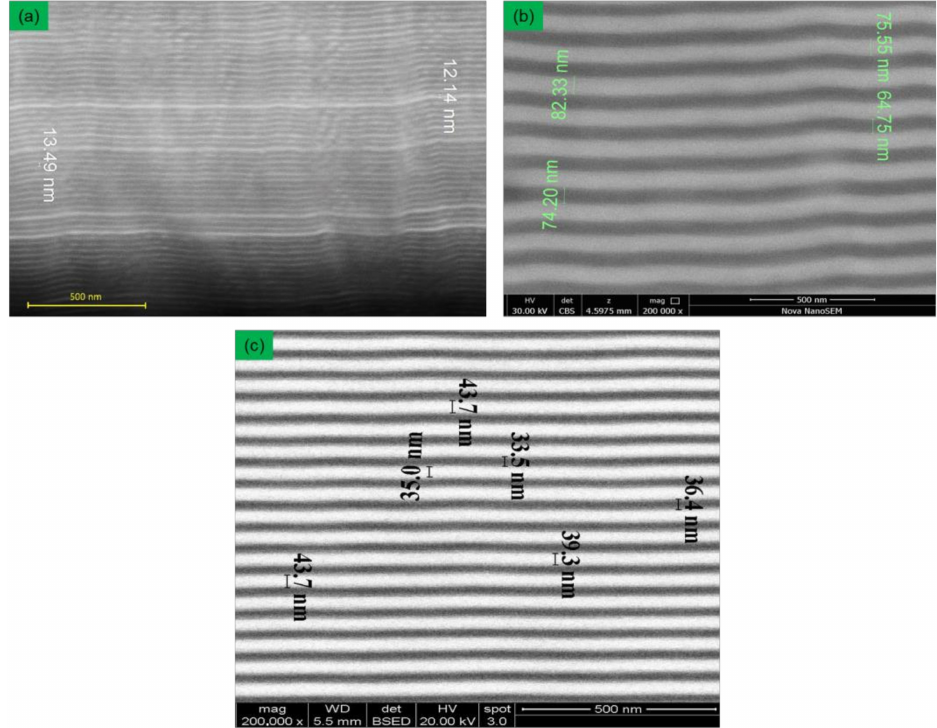
Figure 3. Cross-section images of multilayer (TiZr)N/NbN coatings: ( a ) deposition time of 10 s; ( b ) deposition time of 40 s; ( c ) deposition time of 20